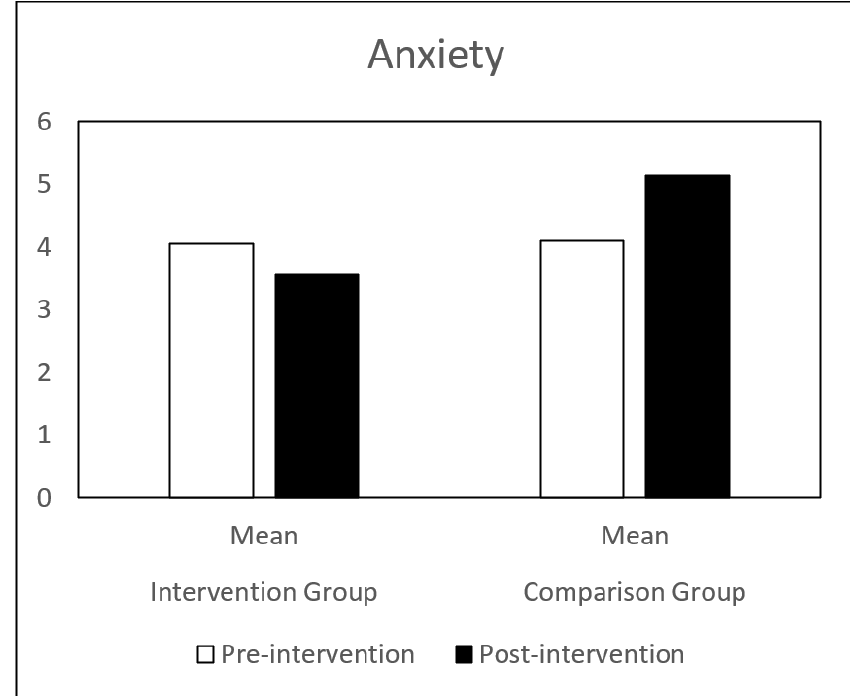
Figure 3. Physical Appearance and intervention. Intervention Attributes mean in IG and CG at pre- and post-intervention.